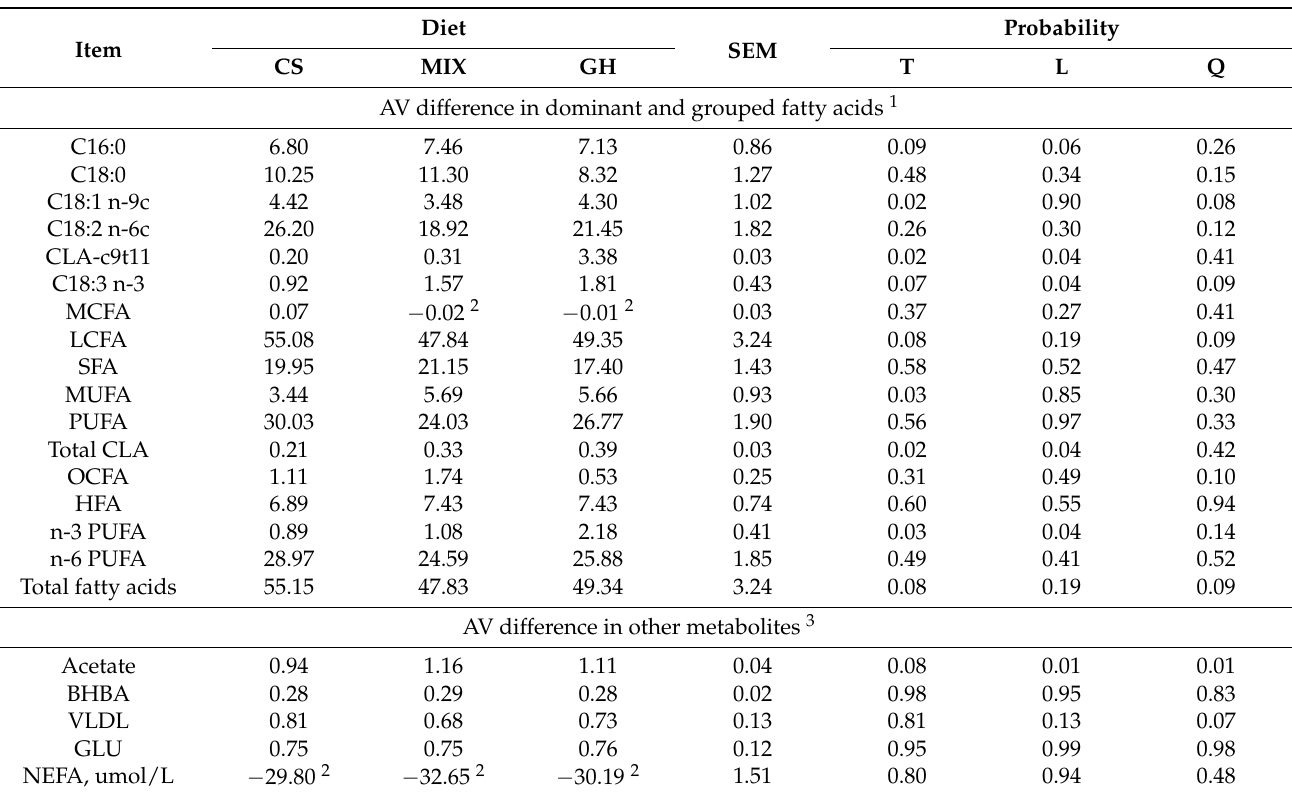
Table 6. Effects of different dietary forage sources on arteriovenous (AV) differences in dominant and grouped fatty acids (mg/100 mL) and other metabolites (mM unless otherwise noted) in the mammary glands of